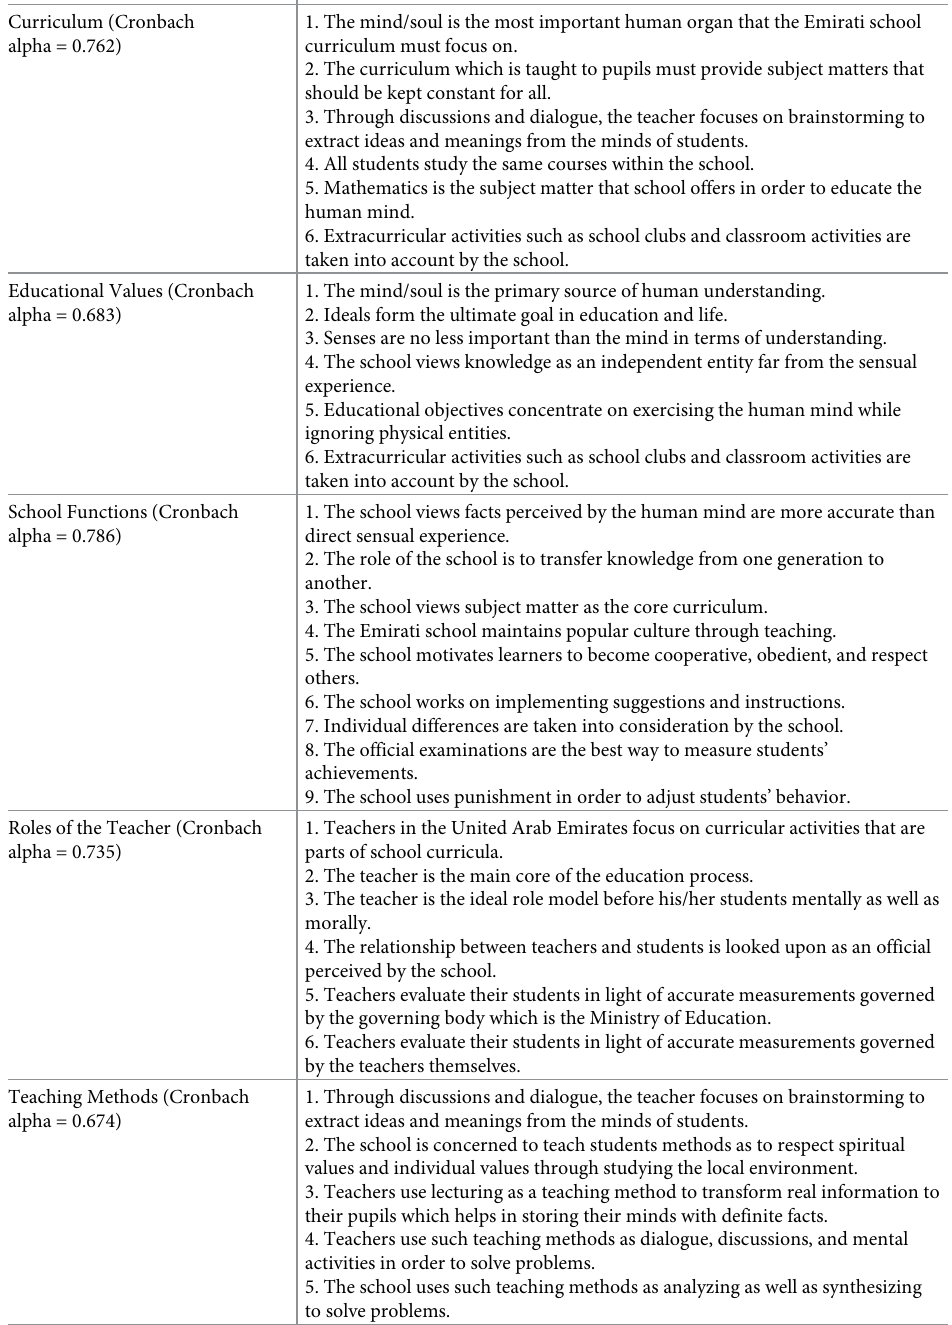
Table 2. Distribution of questions among the survey 5 domains (adopted from Momany et al.